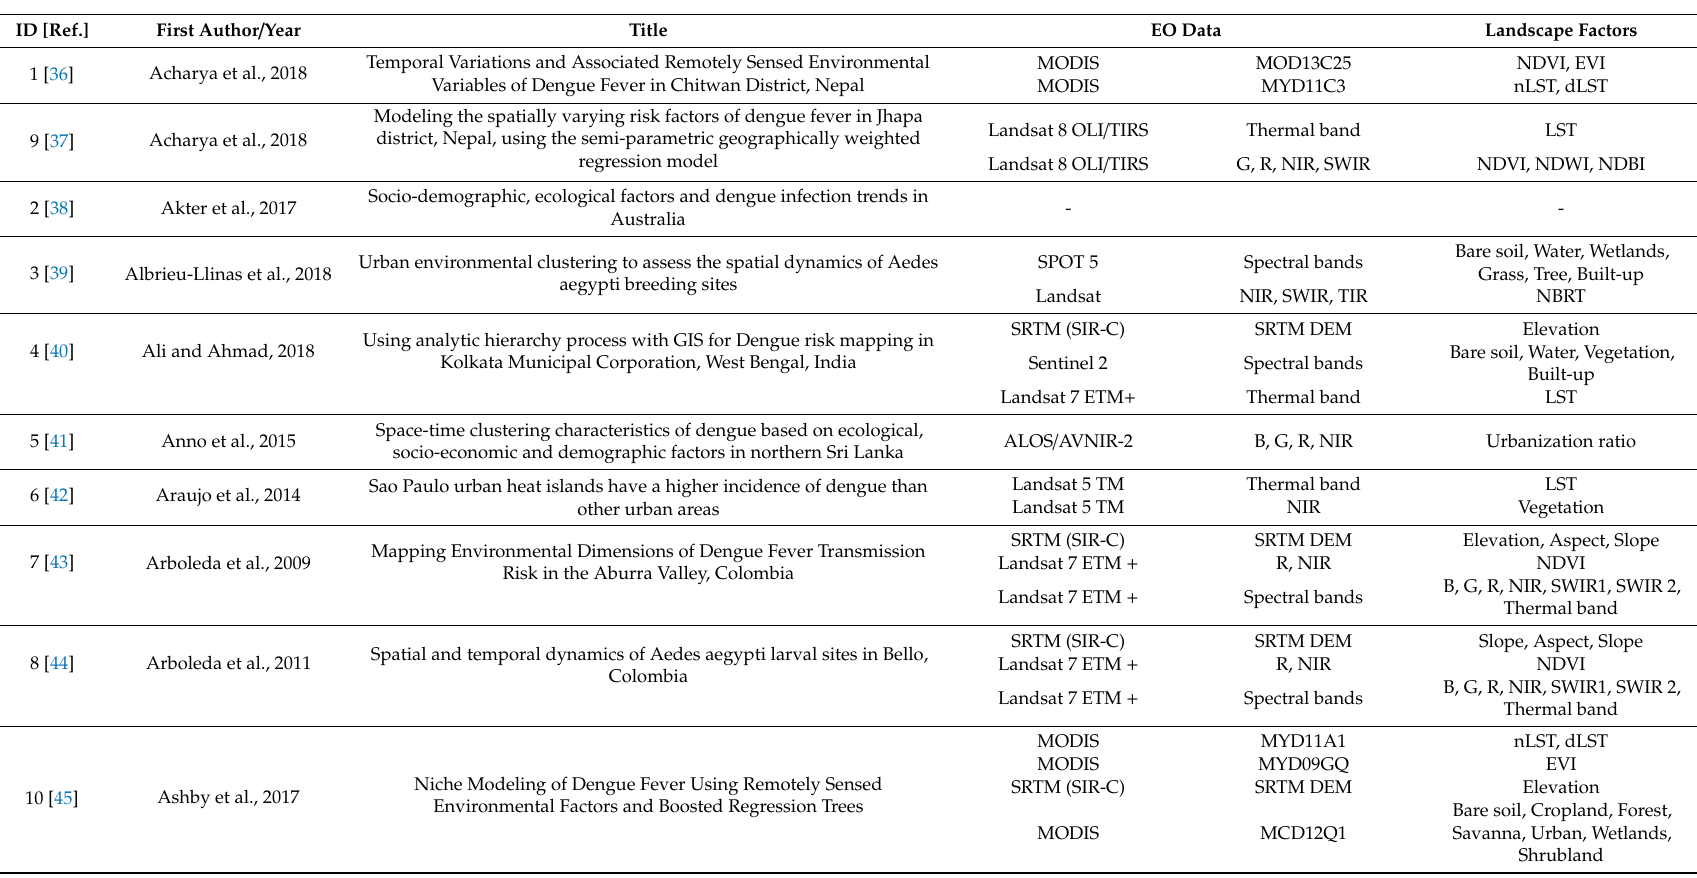
Table A2. Satellite EO data and dengue landscape factors extracted each of the 101 relevant articles derived from the semi-supervised framework of literature. ID